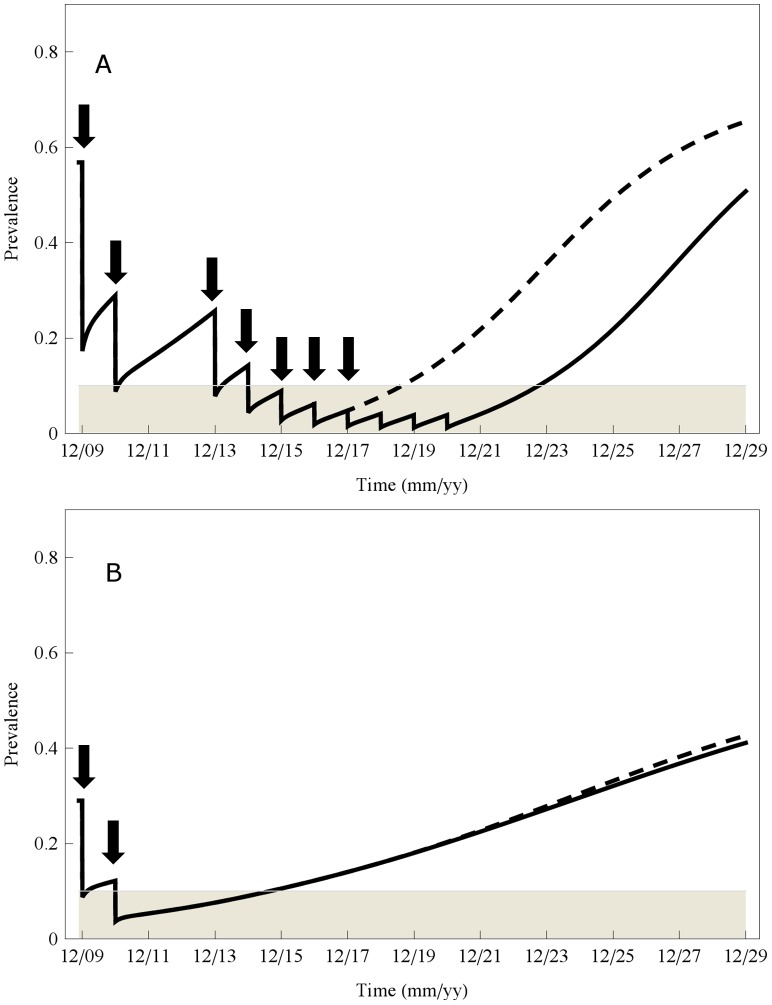
Projected rebound of infection in villages V2 and V6 after community-based treatment for two years.Graphs indicating the projected 20-year annual infection prevalence experience of two area villages, one of initially high prevalence (village 6, panel A) and one of moderate prevalence (village 2, panel B) during and after a 2-year annual community-wide drug administration campaign followed by a 2-year treatment hiatus (C-C-H-H). The timing of initial treatments is indicated by downward arrows. In the high-prevalence village (panel A), community coverage at 70% adherence among children and 50% adherence among adults reduces school age prevalence below the desired 10% target (gray zone) in two years. However, subsequent implementation of a treatment ‘holiday’ for 2 years results in rapid return of school age prevalence to moderate-level prevalence. At that point, re-implementation of treatment through an annual school age coverage results in continued suppression of prevalence to the <10% level. However, if school age treatment is again suspended after 4 years (dashed line) or 8 years (solid line) of retreatments, childhood prevalence is projected to slip above 10% within 3 years. By contrast, in panel B (lower prevalence Village 2), school age prevalence is adequately suppressed by 2 years of community-based treatment, after which local school age prevalence is expected to remain below 10% (gray zone) for at least 4 years. Here, dashed and solid lines indicate that the duration of school age treatment of village 6, whether for shorter (dashed line) or longer periods (solid line), has only marginal effect on the rebound of infection prevalence that is expected in Village 2.